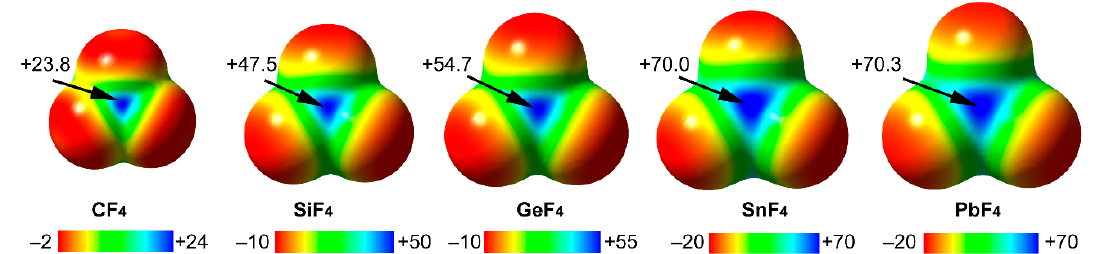
Figure 2. MEP surfaces of tetrafluorides of group 14 of elements. CF 4 , SiF 4 , and GeF 4 at the B3LYP / 6-311 + G* level of theory and SnF 4 and PbF 4 at the B3LYP / LANL2DZ level of theory. Isosurface 0.001 a.u.